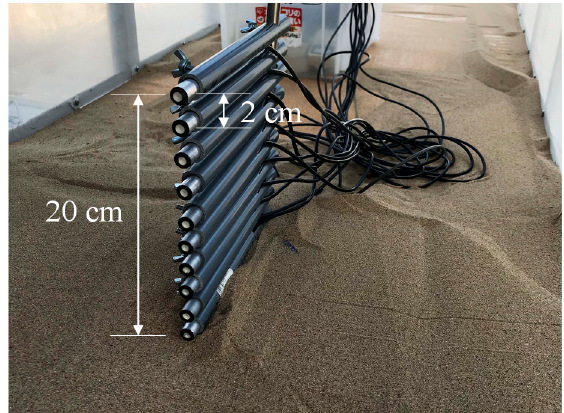
Figure 3. Photograph of the piezoelectric blown-sand meter used in this study.